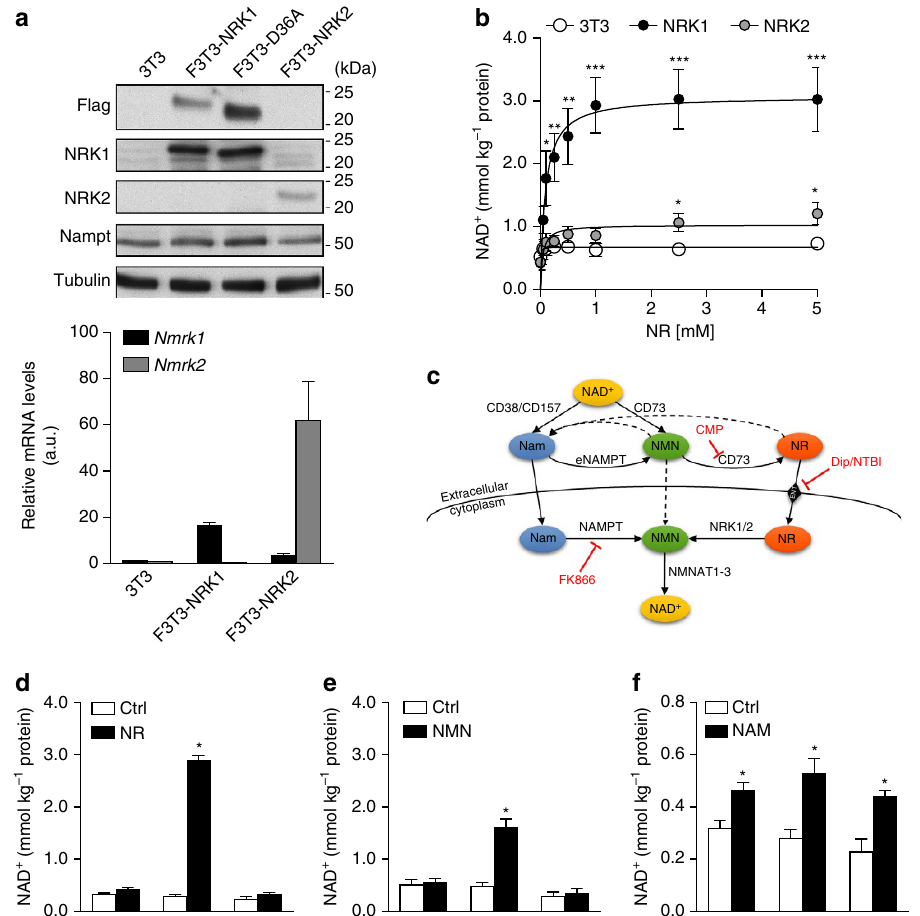
Figure 2 | Slight overexpression of NRKs potentiates NR- and NMN-driven NAD þ synthesis. ( a ) NRK1 and NRK2 protein expression and mRNA levels in NIH/3T3 and stable cell lines with one additional copy of either of NRK (F3T3 cells). ( b ) NAD þ measurement in NR dose-response treatment of F3T3 cells. ( c ) Schematic of NAD þ precursors metabolism ( d – f ) NAD þ measurement in F3T3 cells treated for 6h with 0.5mM NR ( d ), 0.5mM NMN ( e ) and 5.0mM NAM ( f ). Results shown are mean ± s.e.m., * P o 0.05, ** P o 0.01, *** P o 0.001 versus ctrl by two-sided unpaired T -test ( n ¼ 3).